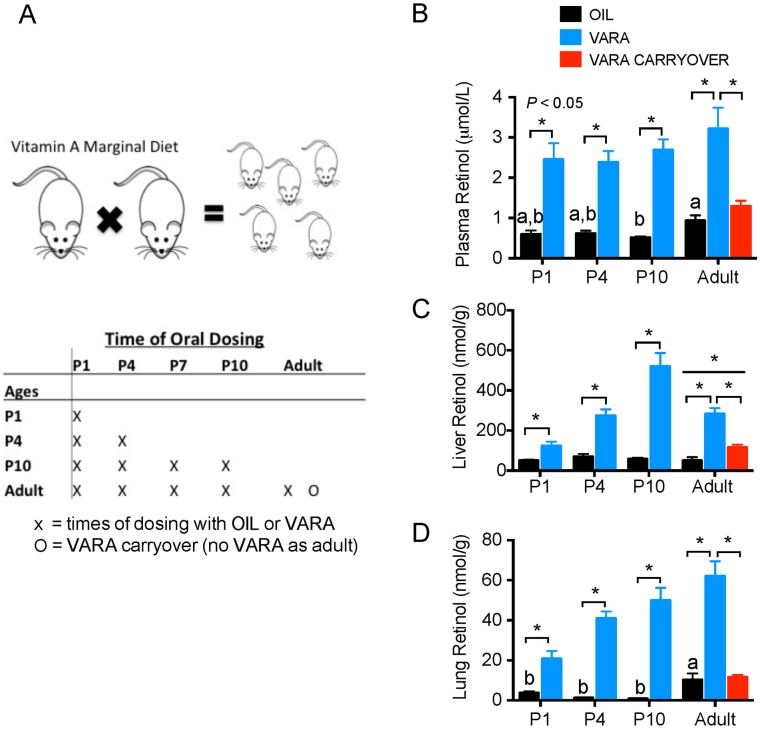
Experimental design and total retinol concentrations in plasma, liver, and lung of neonatal rats to adult-age rats fed VAM diet supplemented with or without VARA.Experimental design and treatment schedule (1A), and total retinol concentrations in plasma (B), liver (C), and lung (D) of control (oil-treated) neonates nursed by dams fed vitamin A marginal (VAM) diet, oil placebo) and VARA supplemented rats at postnatal day (P)1, P4, P10 and adult age. Sprague-Dawley offspring were generated by mating female and male rats; dams were fed marginal VA diet, which was maintained throughout gestation and postnatally, and after weaning in the offspring that reached adult age. Pups were randomly assigned to receive oil or VARA treatments at five ages. The adult group marked 0 received VARA at neonatal days P1-P10, but not at adult age, to assess any carry over effect of neonatal VARA supplementation at adult age. For all ages, the final treatment with oil or VARA was administered 6 h before euthanasia and tissue collection (A). Data in B, C, and D are shown as mean ± SEM, n ≥ 5/group. One-way ANOVA with posthoc analysis was used to determine differences between oil-treated groups, indicative of differences due to ontogeny; means without a common letter differ significantly, P < 0.05. For each age, VARA versus Oil groups were compared by t-test; * indicates P < 0.05. In C, linear trends with age were determined for the Oil and VARA groups separately. Abbreviations: P, postnatal day; VAM, vitamin A marginal; VARA, vitamin A with 10% retinoic acid.